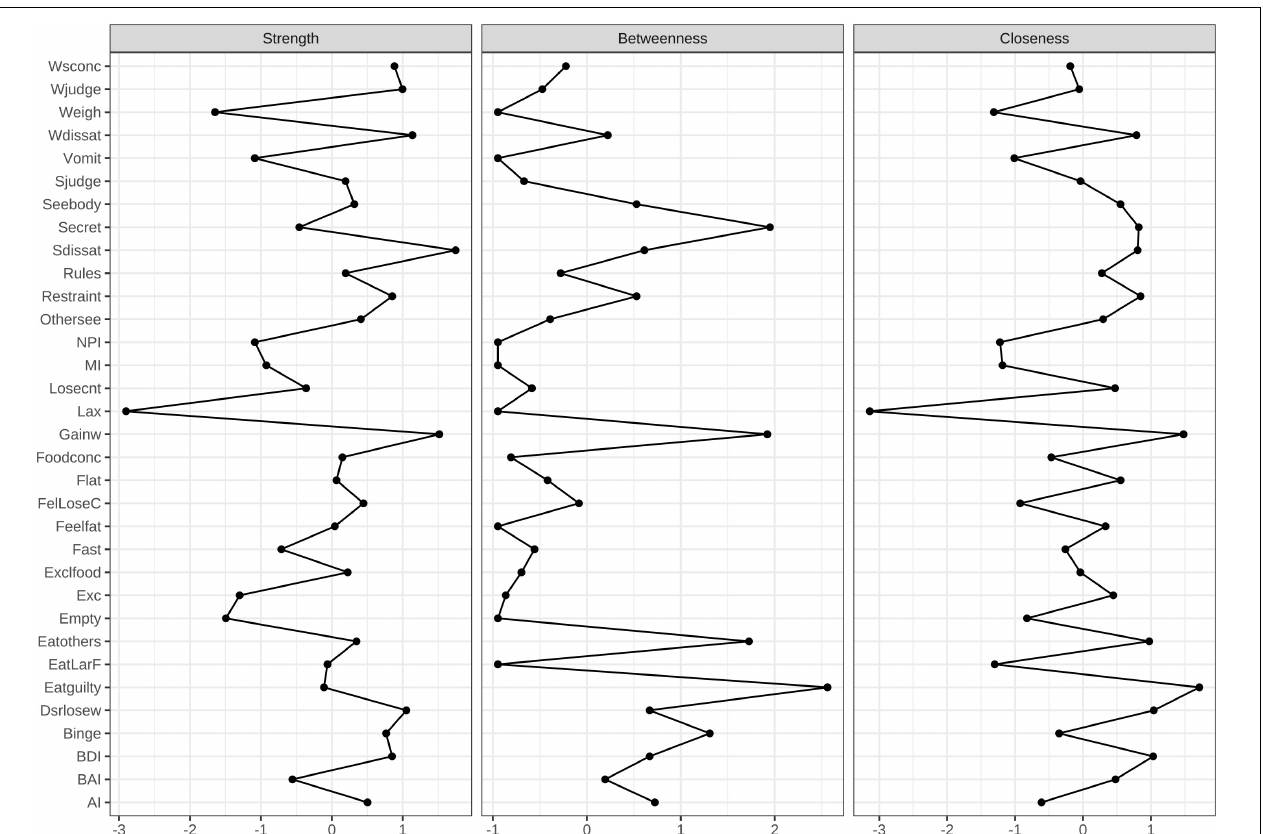
FIGURE 2 | Centrality measures for the BN network representing the strength, closeness, and betweenness of each node. Higher numbers indicate that the item is more central to the network.